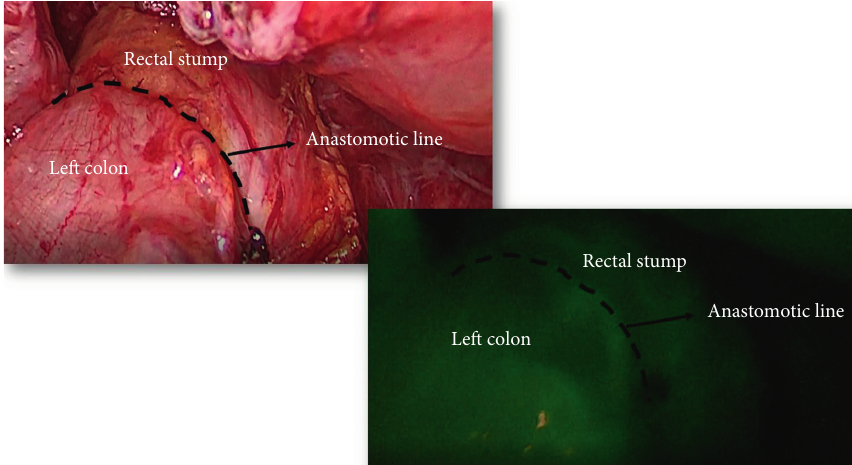
Figure 2: ICG-indocyanine green intraoperative angiography showing bowel